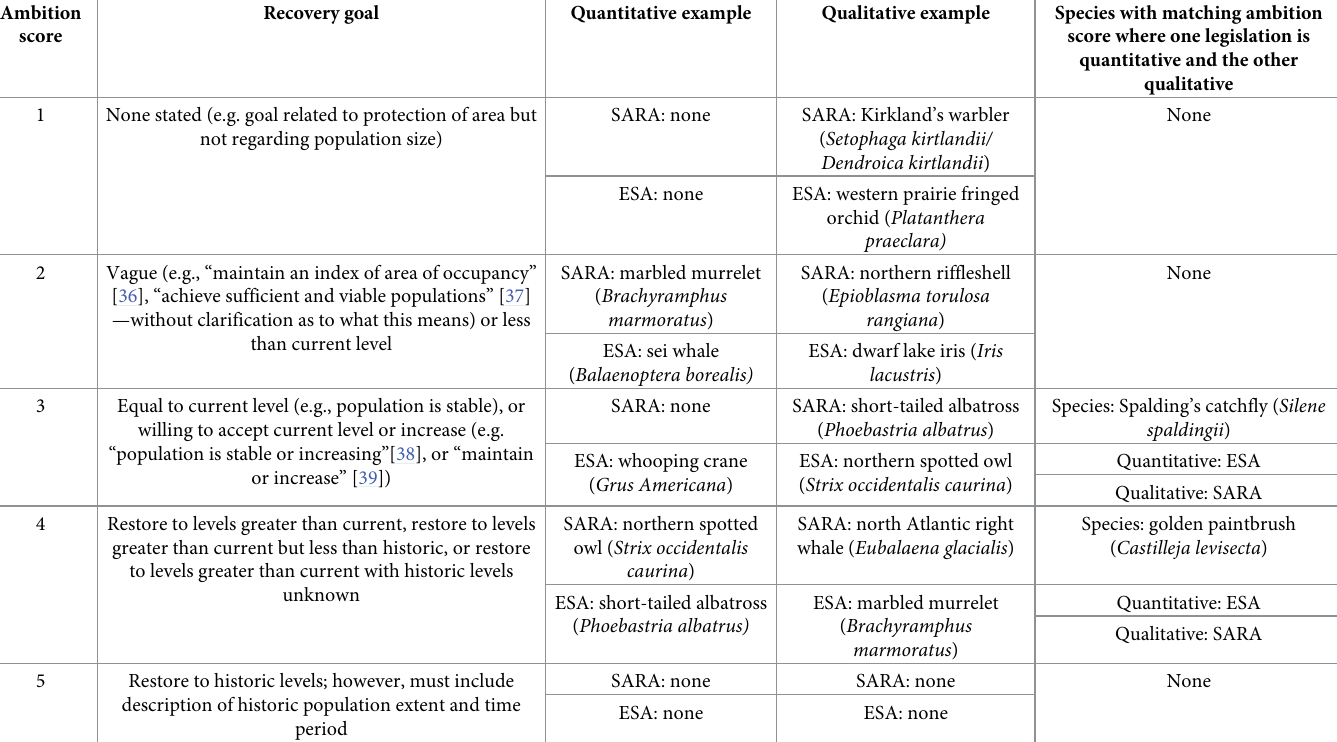
Table 1. Recovery ambition scoring guide for species’ recovery plans and strategies under Canada’s Species at Risk Act (SARA) and the US Endangered Species Act (ESA), modified from McCune et al. [18]. Ambition